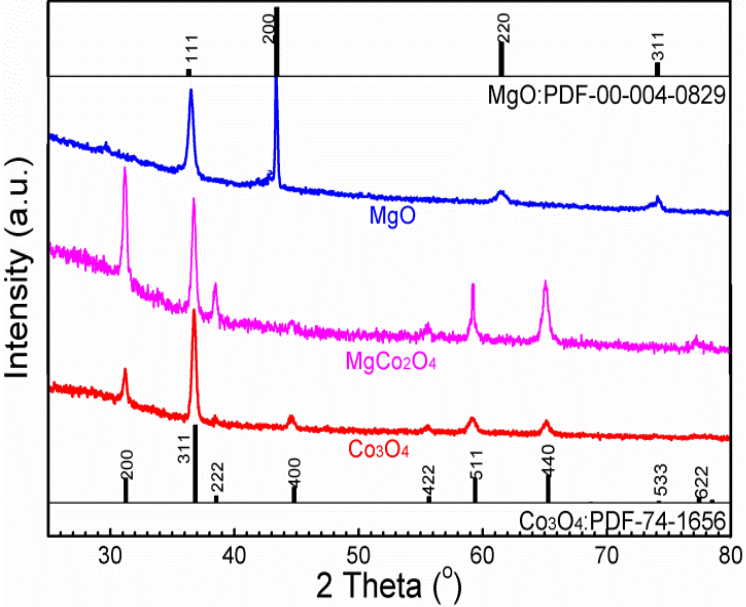
Figure 1. XRD patterns of Co3O4, MgCo2O4, and MgO samples obtained by